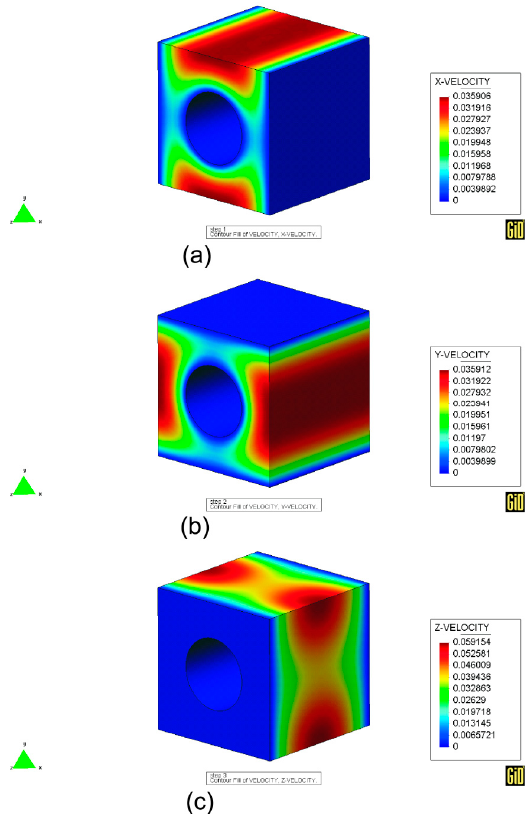
, ( b ) κ 2 , ( c ) κ 3 . 2 3 1